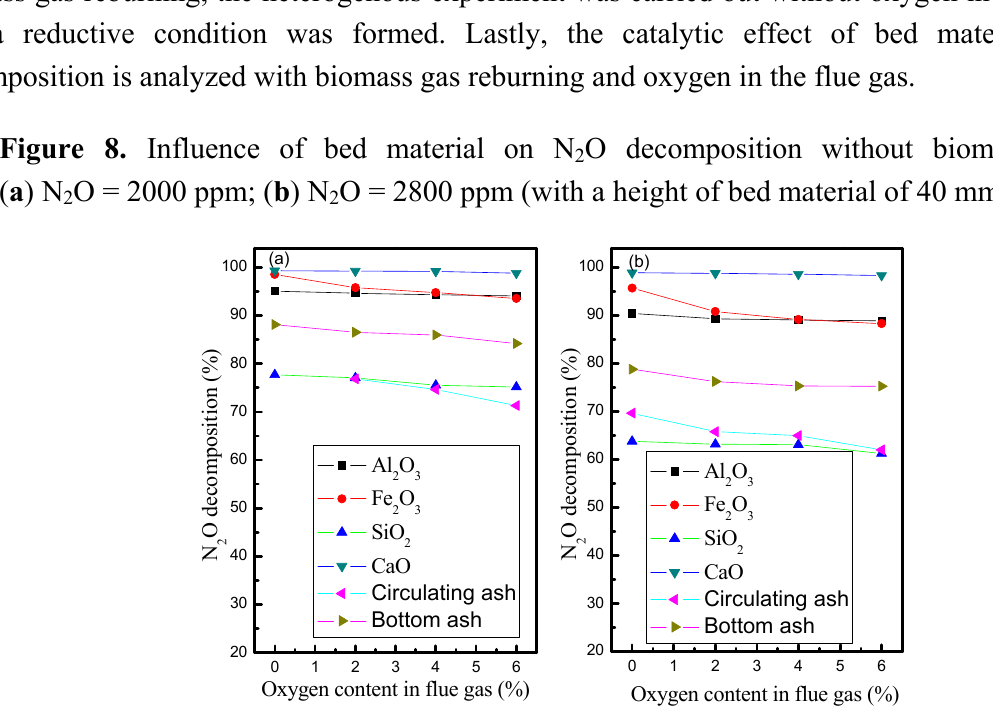
O/N /O , 900 °C). 2 2 2